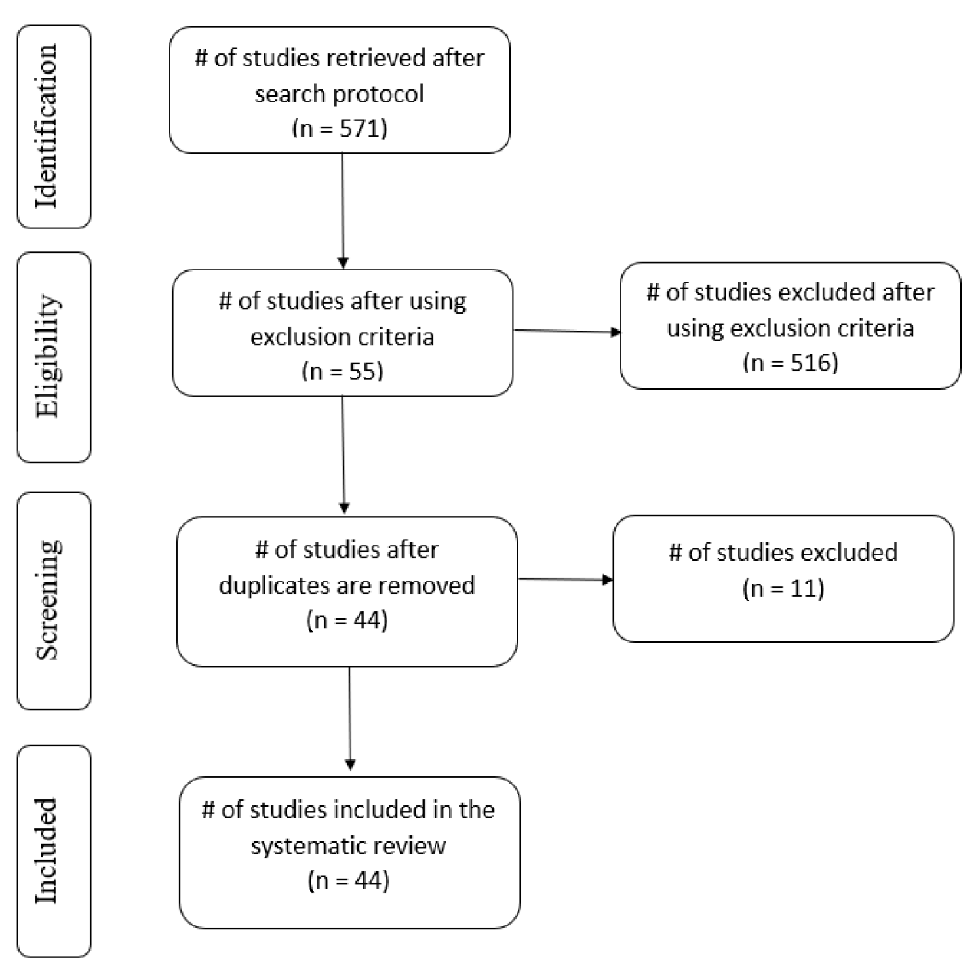
Figure 1. PRISMA flow chart showing the results of searches.